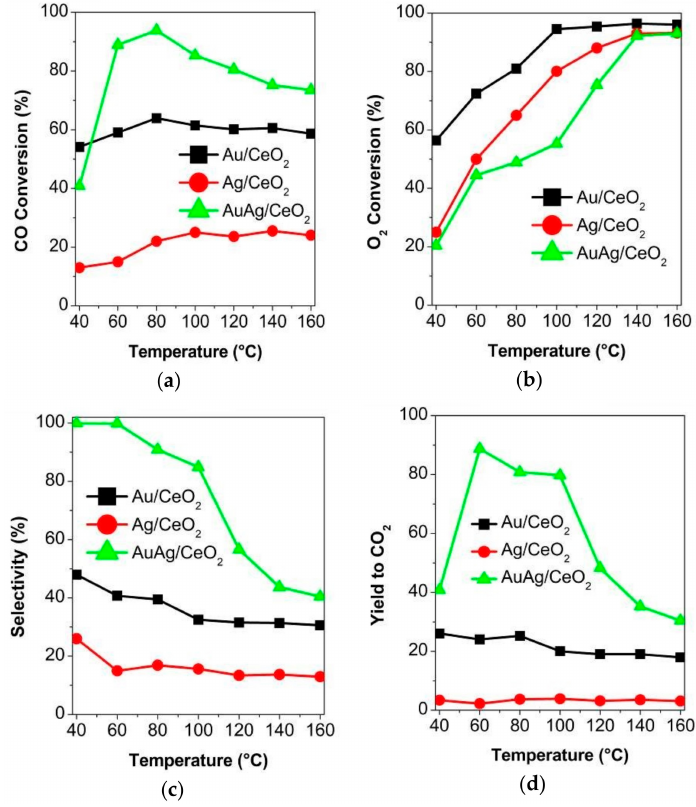
Figure 7. Catalytic activity on the CO-Preferential oxidation reaction: ( a ) conversion of CO; ( b ) conversion of O 2 ; ( c ) selectivity to CO 2 ; ( d ) yield to CO 2